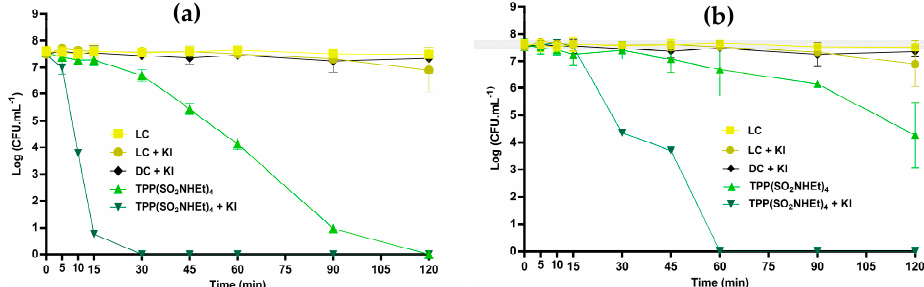
Figure 6. Photodynamic inactivation of MRSA in the presence of PS TPP(SO 2 NHEt) 4 at 5.0 µ M ( a ) and 1.0 µ M ( b ), in the presence and absence of KI at 100 mM, during 120 min of irradiation (white light at an irradiance of 25 mW cm − 2 ). Each value represents the mean ± standard deviation of three independent assays, with three replicates each.